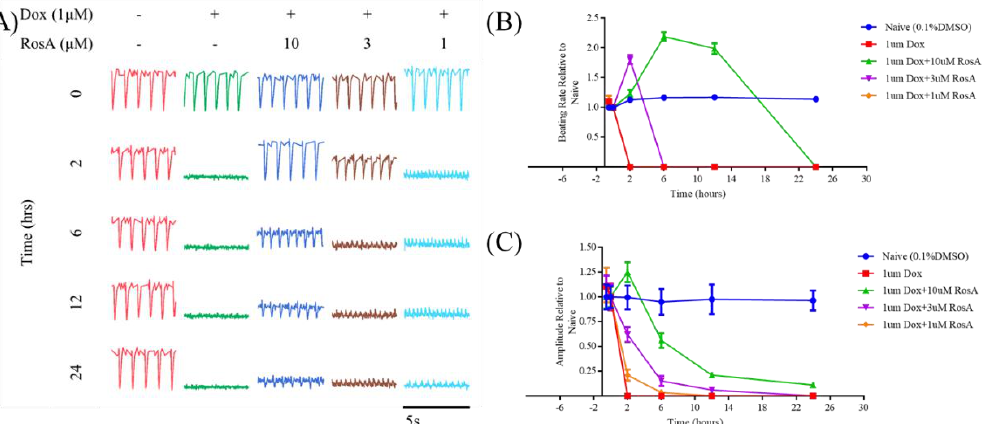
Figure 7. The myocardial protective effect of RosA in Dox-induced dysfunctional cardiomyocytes. ( A ) Beating patterns, ( B ) beating rates, and ( C ) amplitude of dysfunctional cardiomyocytes treated by various concentrations of RosA at selected time points (0, 2, 6, 12, and 24 h). All data were normalized by 0 h. * p < 0.05, ** p < 0.01, *** p < 0.001, 1 μM Dox -treated was the model group; 0.25% DMSO-treated was the negative control group, compared with the model group. Results are expressed as mean ± SD ( n = 3).